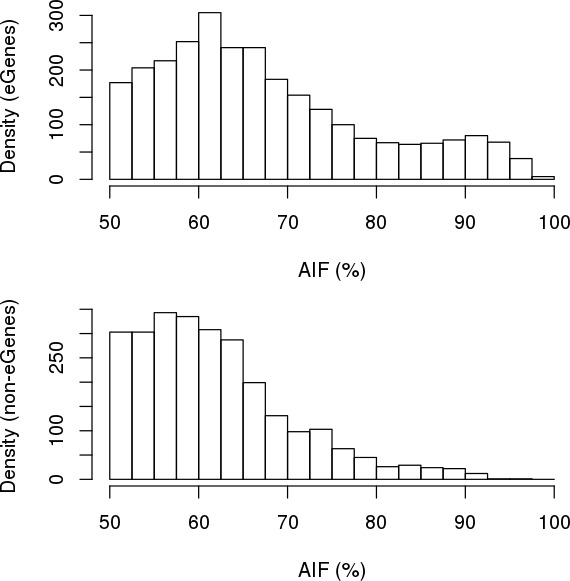
Comparing ASE between eGenes and non-eGenes.The strength of ASE for each gene was defined as the fraction of RNA transcripts that were estimated to originate from the allele with higher expression (hereto referred to as ‘allelic imbalance fraction’, AIF). Histograms showing the distribution differences in AIF calculated using MBASED on 215 iPSCORE individuals between the 56 eGenes (top) and the 90 expressed genes in the MHC region that were not eGenes (bottom).